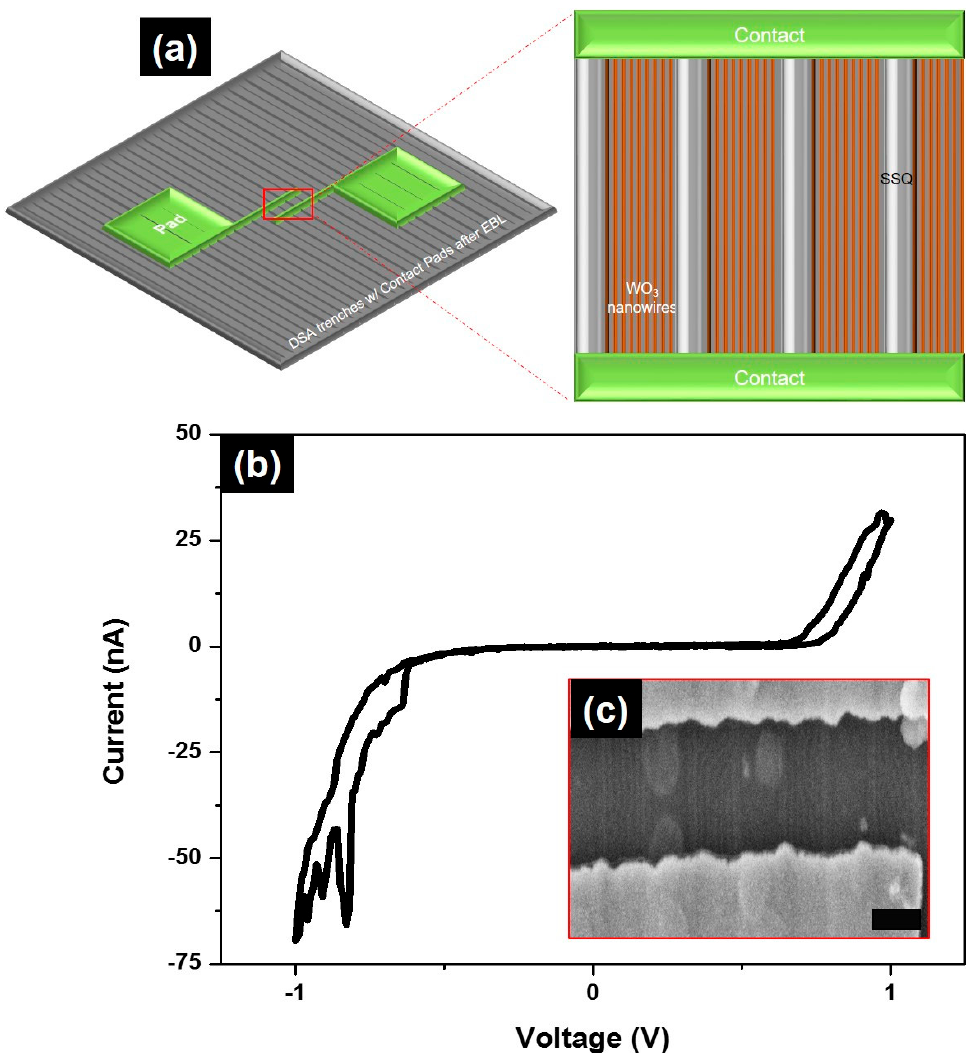
Figure 4. ( a ) Scheme showing large scale area of contact pads on SSQ patterned substrates containing WO 3 nanowires within trenched features from the initial PS- b -P4VP BCP template. ( b ) I - V curve measured on WO 3 nanowires contacted with Ni pads. ( c ) Inset shows aligned WO 3 nanowires within trenches; scale bar represents 200 nm.